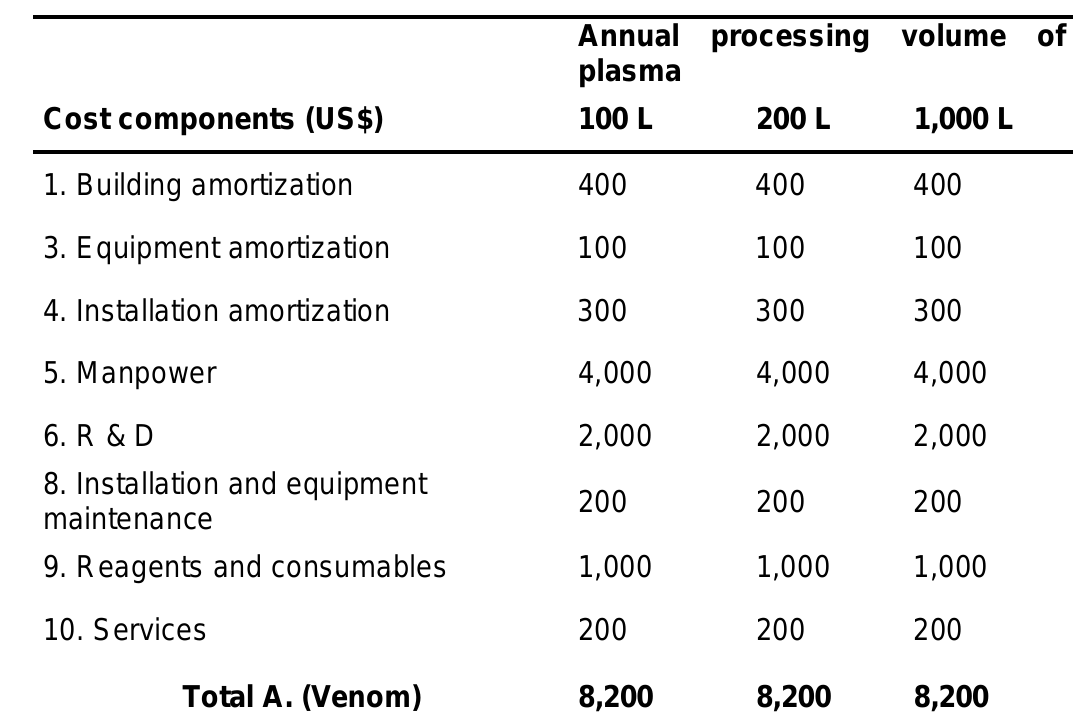
Table 2: Costs associated to the first stage of antivenom production: A. Venom